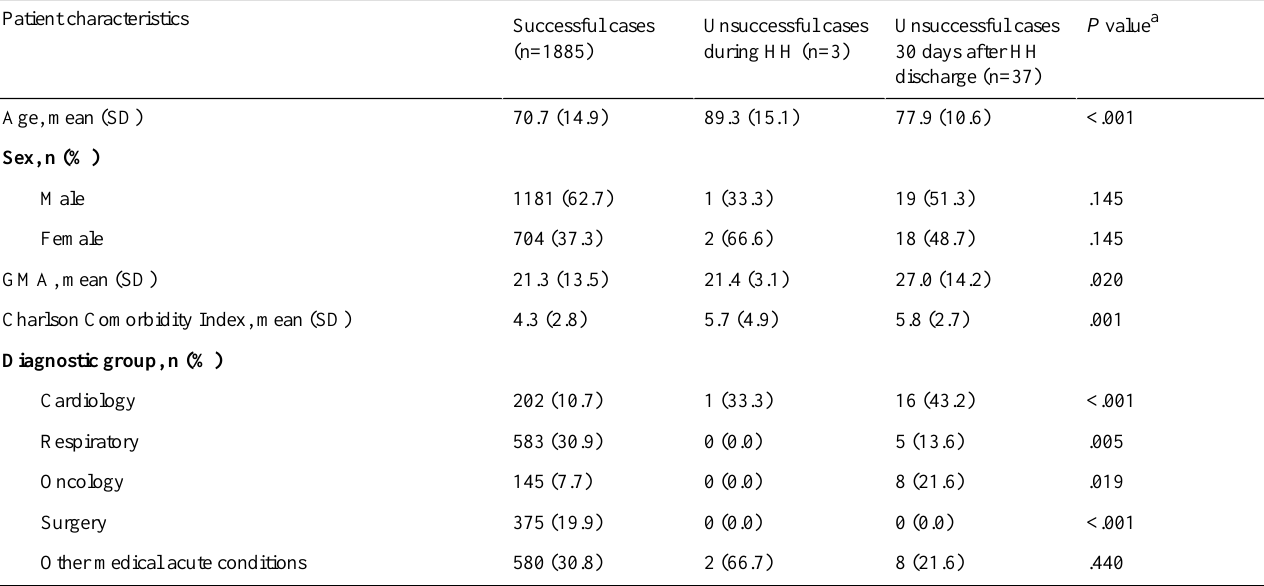
Table 1. Clinical characteristics of successful and unsuccessful home hospitalization (HH) cases (n=1925) based on